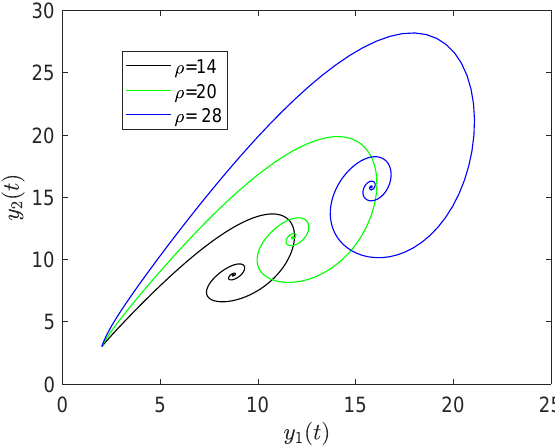
Figure 43. Phase portraits of y 1 and y 2 when varying ρ .